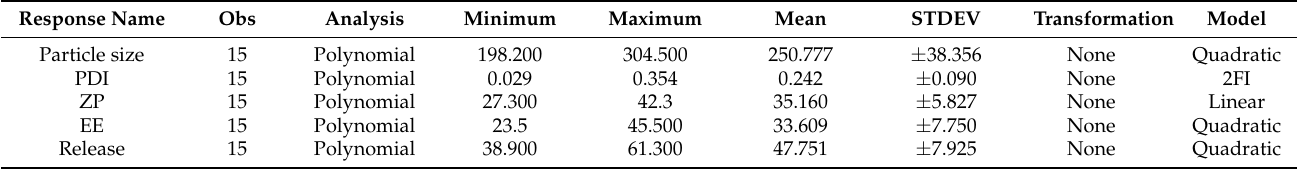
Table 4. Experimental design summary of